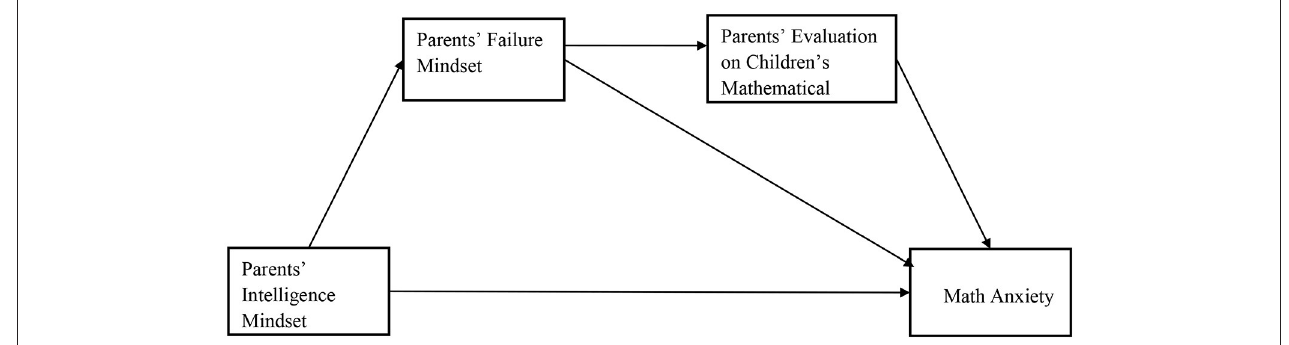
FIGURE 1 | The hypothesis model of the relationship between